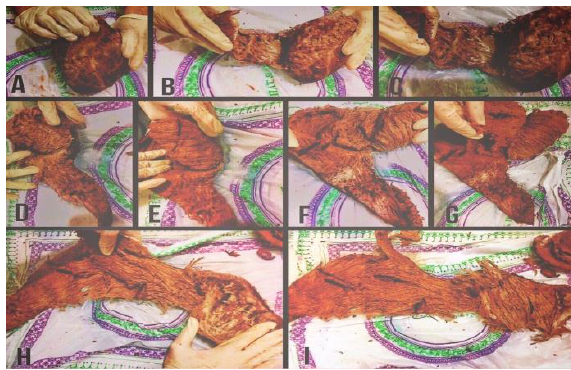
Figure 8. The reomval-procedure of atria, parts of aorta with parts of pulmonary artery and viscera pericardium with pericardial fat.